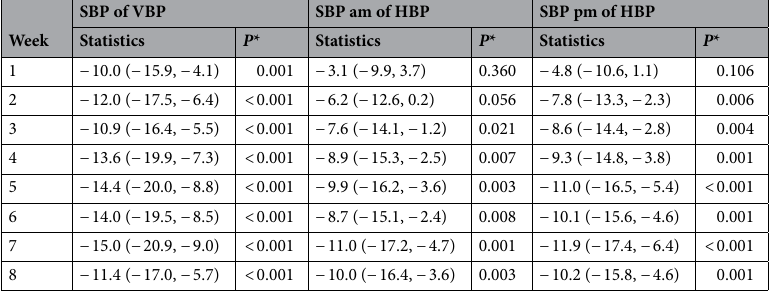
Table 3. Changes in morning SBP from baseline during intervention, mean (95% CI)*. *Adjusted for sex, age, body mass index , drinking, hypoglycemic agents, antihypertensive drug category and reduction of antihypertensive drugs in linear mixed model.